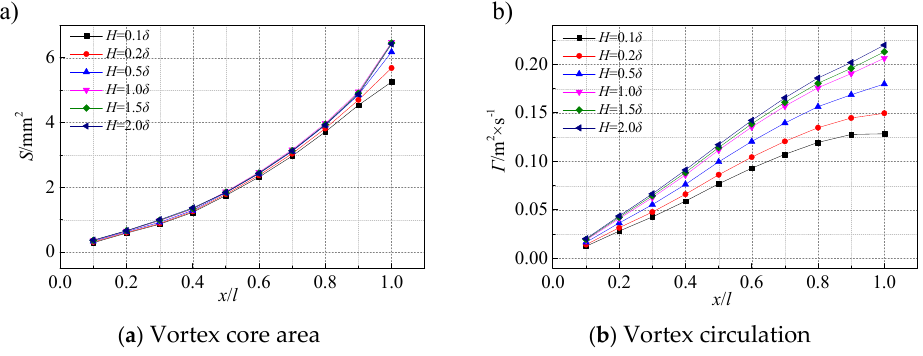
Figure 11. Chordwise distribution of vortex core area and vortex circulation.